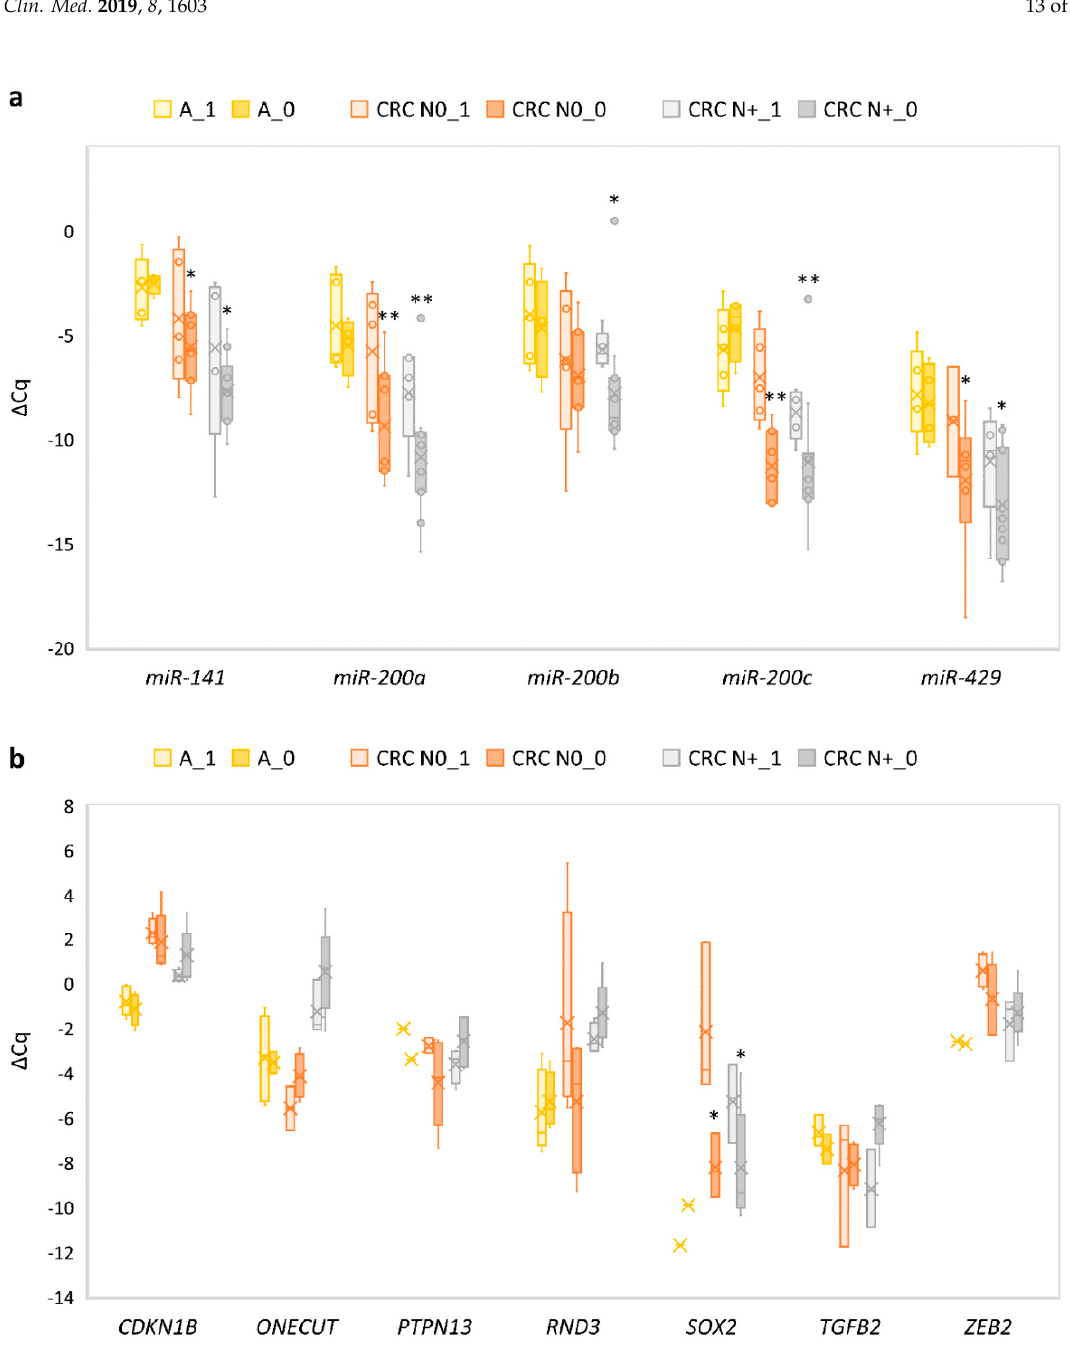
Figure 8. Expression of miR-200 family and their target genes in adenoma, CRC N0 and CRC N + based on E-cadherin expression: ( a ) expression of miR-200 family; ( b ) expression of target genes of miR-200 family. Legend: CRC, colorectal carcinoma; N0, without nodal metastases; N + , with nodal metastases; 1, preserved expression of E-cadherin ( n = 6, n = 6 and n = 8 for adenoma, CRC N0 and CRC N + , respectively); 0, weak or focal loss of E-cadherin ( n = 4, n = 7 and n = 9 for adenoma, CRC N0 and CRC N + , respectively); * p ≤ 0.05; ** p ≤ 0.01.